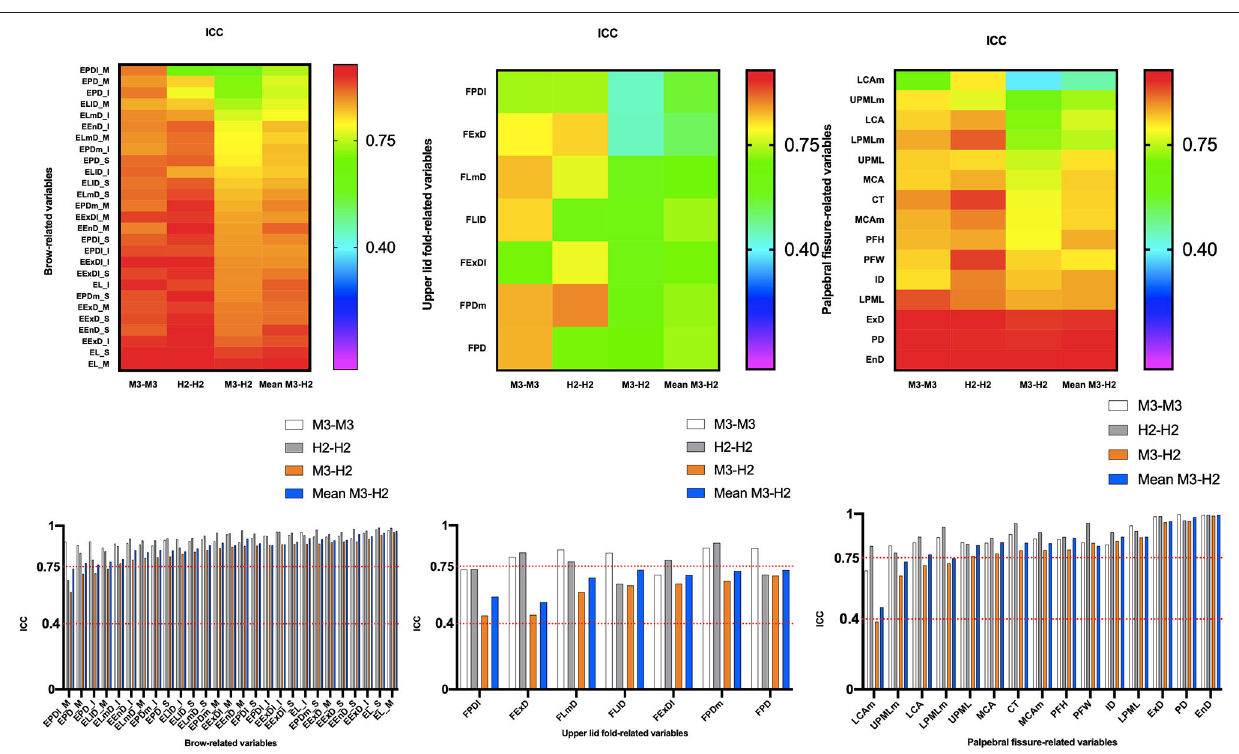
(0.61 and 0.68%), TEM (1.02 and 0.80 units), rTEM (5.51 and 4.43%), and ICC (0.89 and 0.89) for devices M3 and H2 were highly comparable. For inter-device comparisons, the mean MAD, REM, TEM, rTEM, and ICC were 0.63 units, 2.83%, 1.31 units, 7.62%, and 0.79 units, respectively (0.62 units, 2.69%, 1.10 units, 5.57%, and 0.83 units if the mean values of H2 and M3 were used). Inter-device reliability decreased compared to intra-device reliability and all reliability metrics improved when quoting average values, indicating that we can reduce inter-device variation by using the average of the two captured images when the H2 device is used for